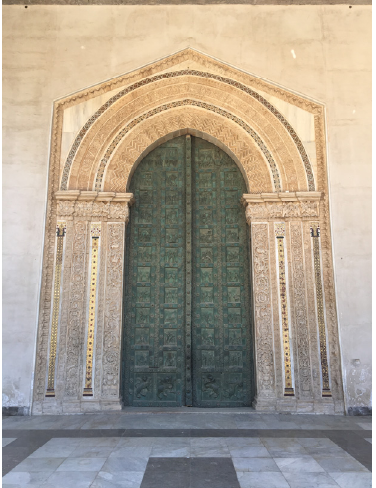
Figure 3. The main portal of the Cathedral of Monreale